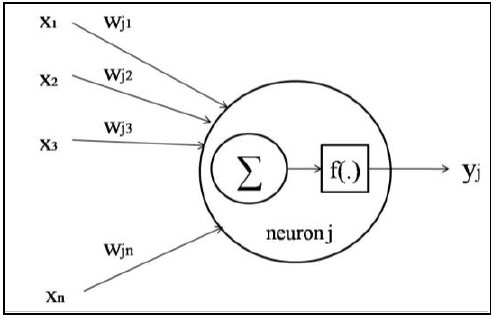
Figure 6. A node of MLP: an artificial